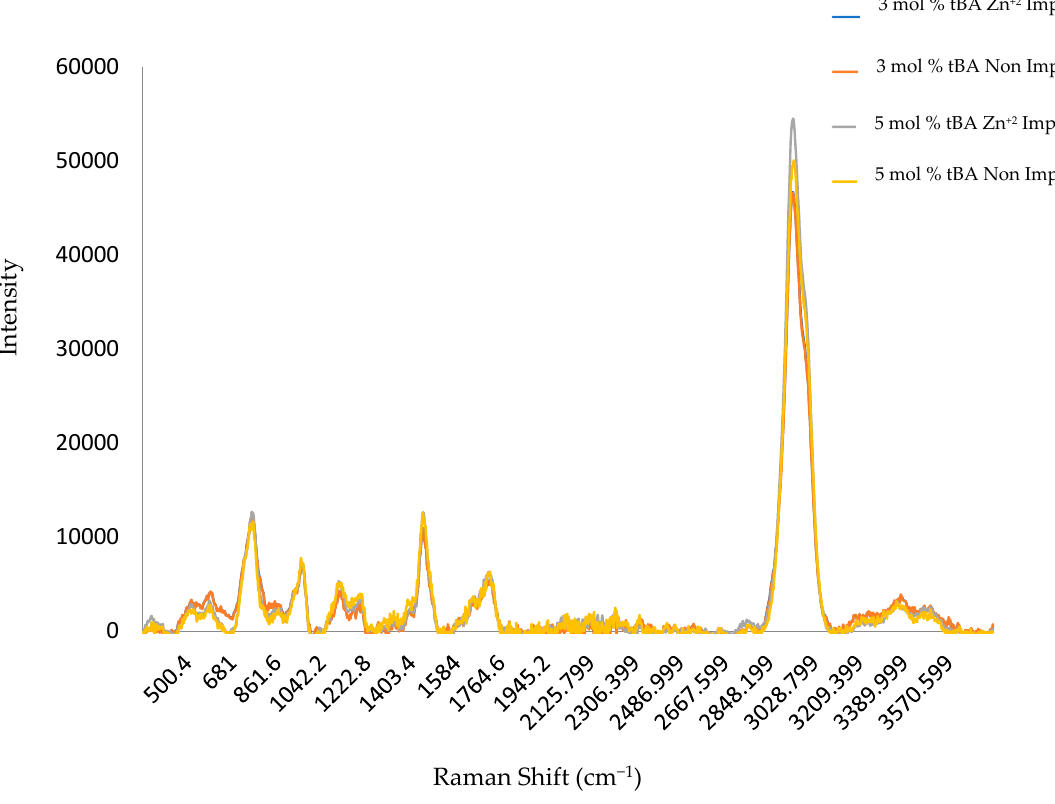
Figure 6. Compiled RAMAN spectra for non-imprinted and zinc imprinted polymer variants. All displayed variants contain 5 mol % EGDA crosslinker .